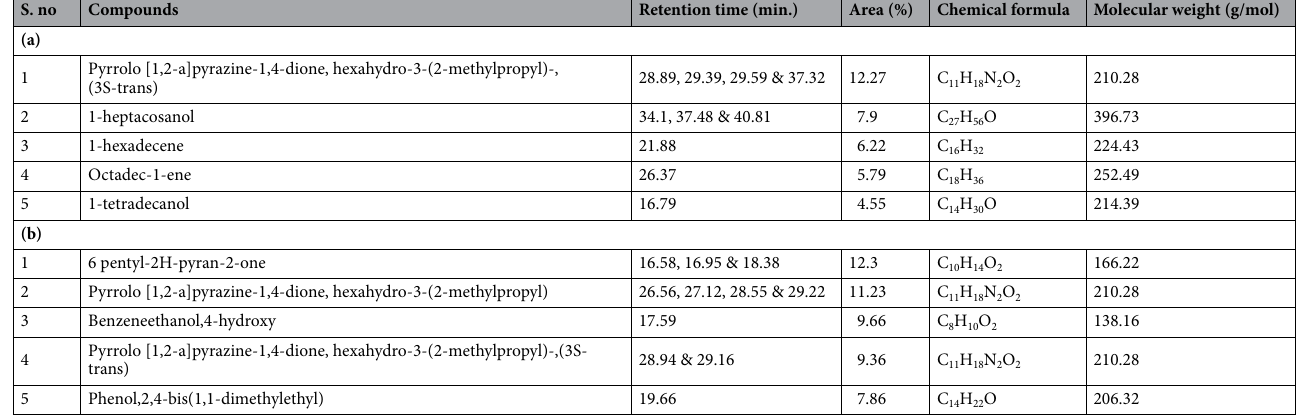
Table 4. Major compounds in culture filtrate of (a) Bacillus subtilis and (b) Trichoderma harzianum identified by GC–MS in ethyl acetate extract.